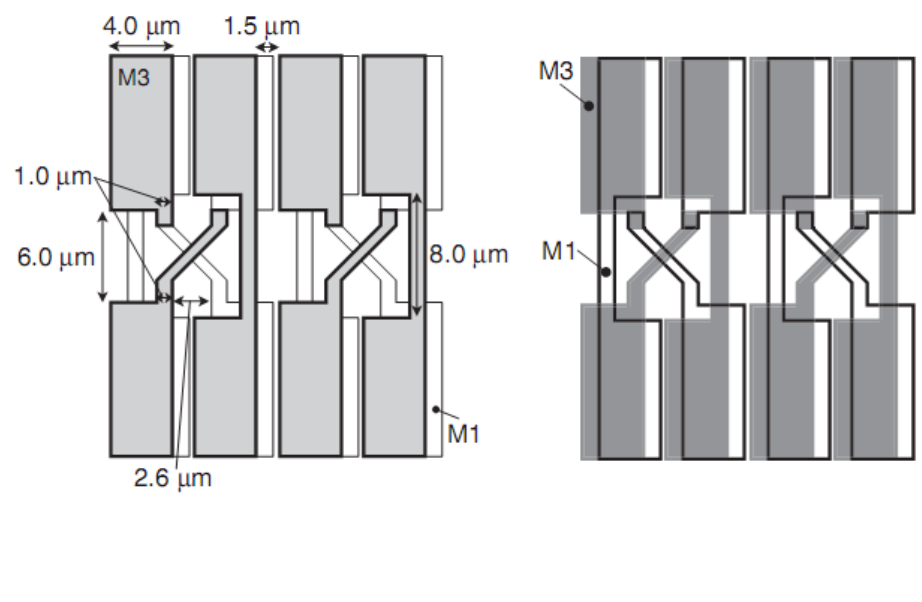
Figure 12. Twisted differential transmission line structure by Ito et al .